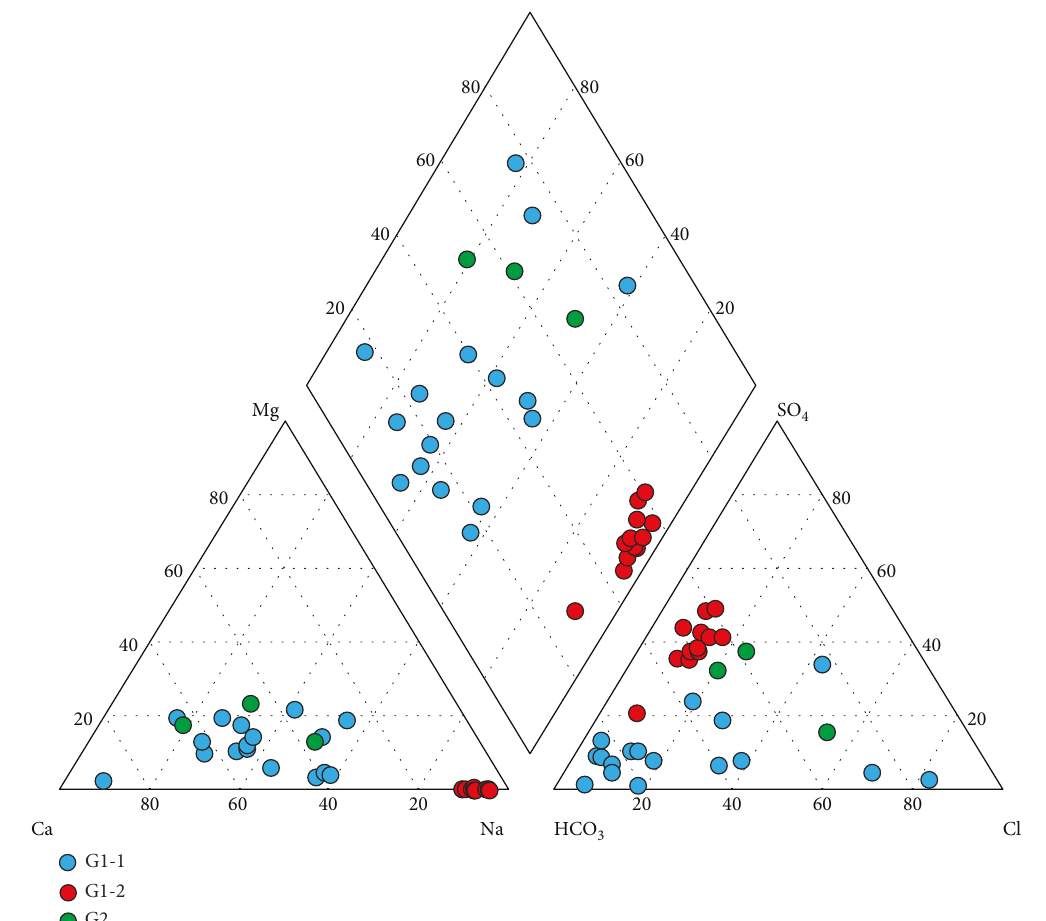
Figure 4: Piper diagram of underground water samples in the research